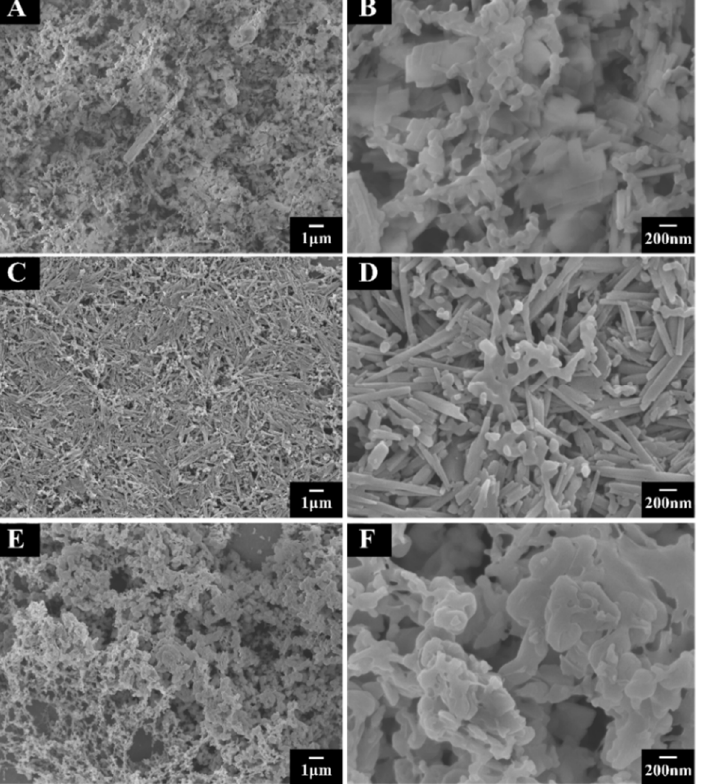
Figure 3. SEM images at different magnifications of as-deposited monolayer composite coatings: ( A , B ) PEMA-huntite, ( C , D ) PEMA-halloysite, and ( E , F ) PEMA-hydrotalcite.